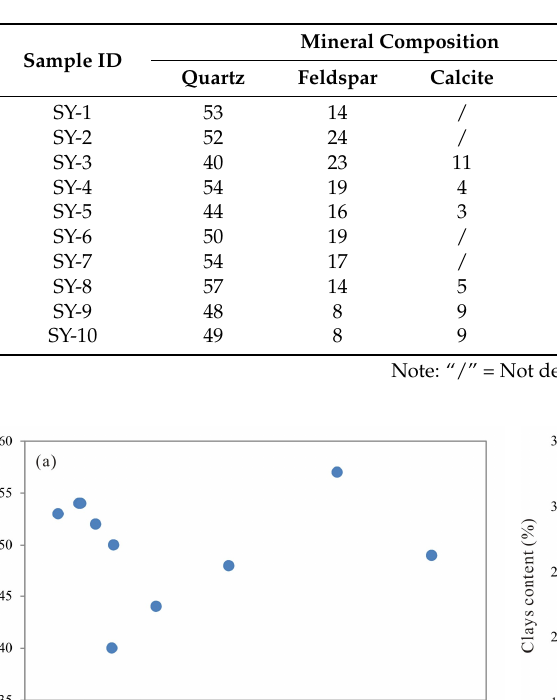
Table 2. Mineralogical composition of the shale samples.